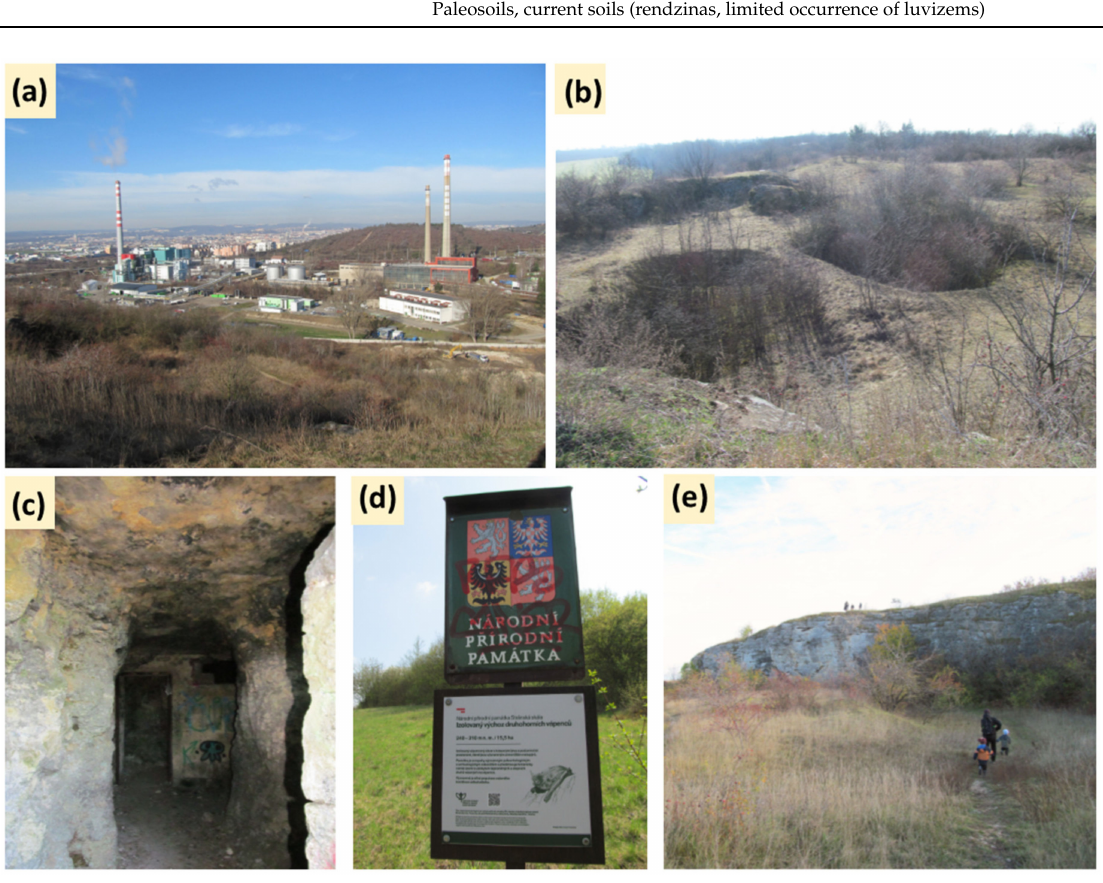
Figure 4. Examples of cultural ecosystem services provided by geodiversity at Str á nsk á sk á la: ( a ) Abandoned valley of Svitava River between Str á nsk á sk á la and B í l á hora Hill is important for palaeogeographical studies; ( b ) Sinkholes on the plateau allow us to study karst features and the impact of old mining on the landscape; ( c ) Anthropogenic underground has strong links to the industrial history of the city and it is also a resource for the modern urban legends; ( d ) Str á nsk á sk á la is a part of the geoheritage of Southern Moravia, protected as a National Natural Monument; ( e ) The site is popular for local people and visitors. Source: personal